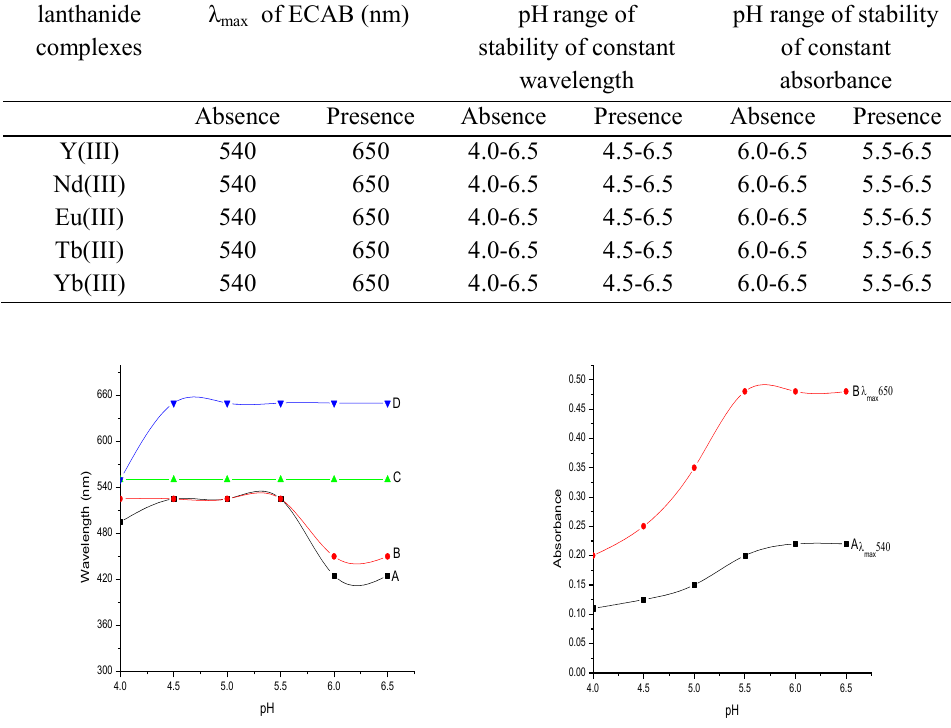
Figure 9. Variation in absorbance at the λ with change in the pH of : max A- λ ,540nm of ECAB-Eu (Binary max complex) B- λ ,650nm of ECAB-CDMEAB- max Eu (Ternary